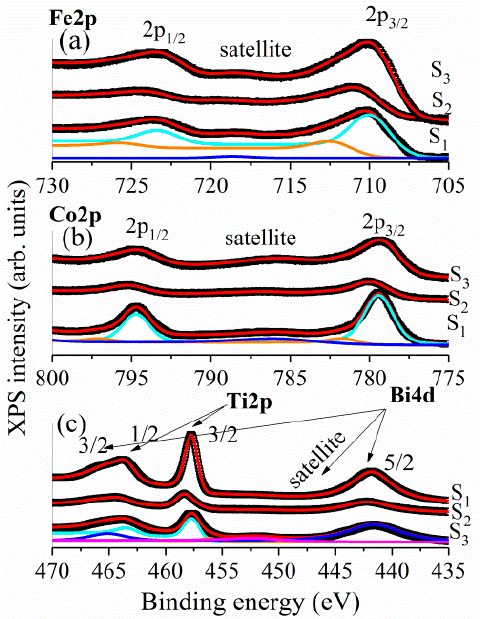
Figure 6. Core levels photoemission of: ( a ) Fe 2p; ( b ) Co 2p; ( c ) Ti 2p and Bi 4d measured on the BNT–BT 0.08 / CoFe 2 O 4 core–shell powders (samples S 1 , S 2 and S 3 ).